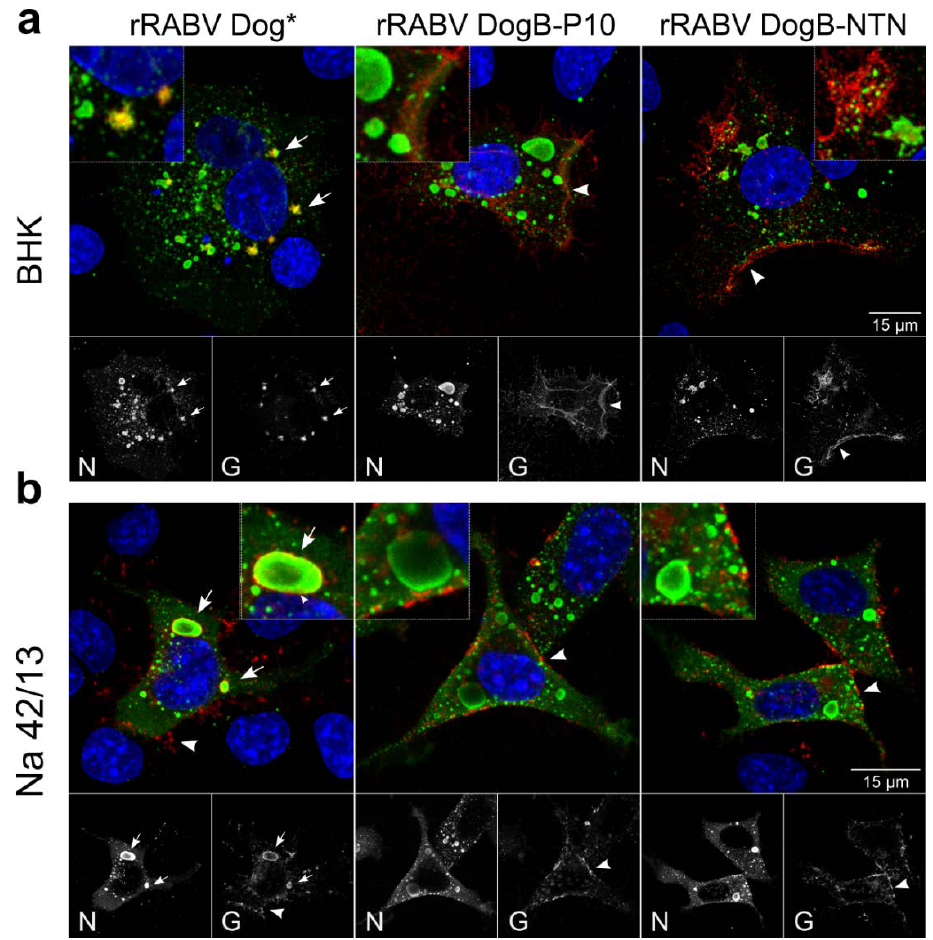
Figure 6. Increased cell surface accumulation of rRABV DogB-P10 and rRABV Dog-NTN G proteins. rRABV Dog*, rRABV DogB-P10, and rRABV Dog-NTN infection of BHK ( a ) and Na 42/13 ( b ) cells at 1 dpi. Confocal laser-scanning analysis was performed after immunostaining for glycoprotein G (red) and phosphoprotein P (green). Blue: Hoechst 33342. Arrows: inclusion body-associated G; arrowheads: plasma membrane localization of G.